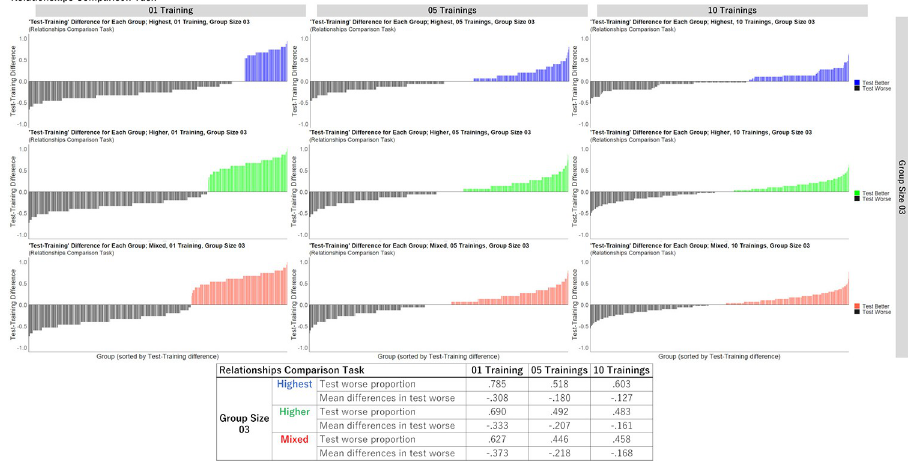
Fig 8. Example of the difference “test accuracy–training accuracy” for each hypothetical group in the computer simulations (relationships comparison task, group size 3). (Bar graphs) Each bar denotes each hypothetical group (5,000 groups in total; sorted by the values of the differences), and the colored bar and black bars denote “test better” (i.e., values above 0) and “test worse” (i.e., values below 0) scenarios, respectively. Upper: population inference task. Lower: relationships comparison task. (Table) Summary of “test worse proportions” (i.e., No. number of test worse cases / 5,000) and “the mean differences in test worse cases” (i.e., the mean of values denoted by the black bars).